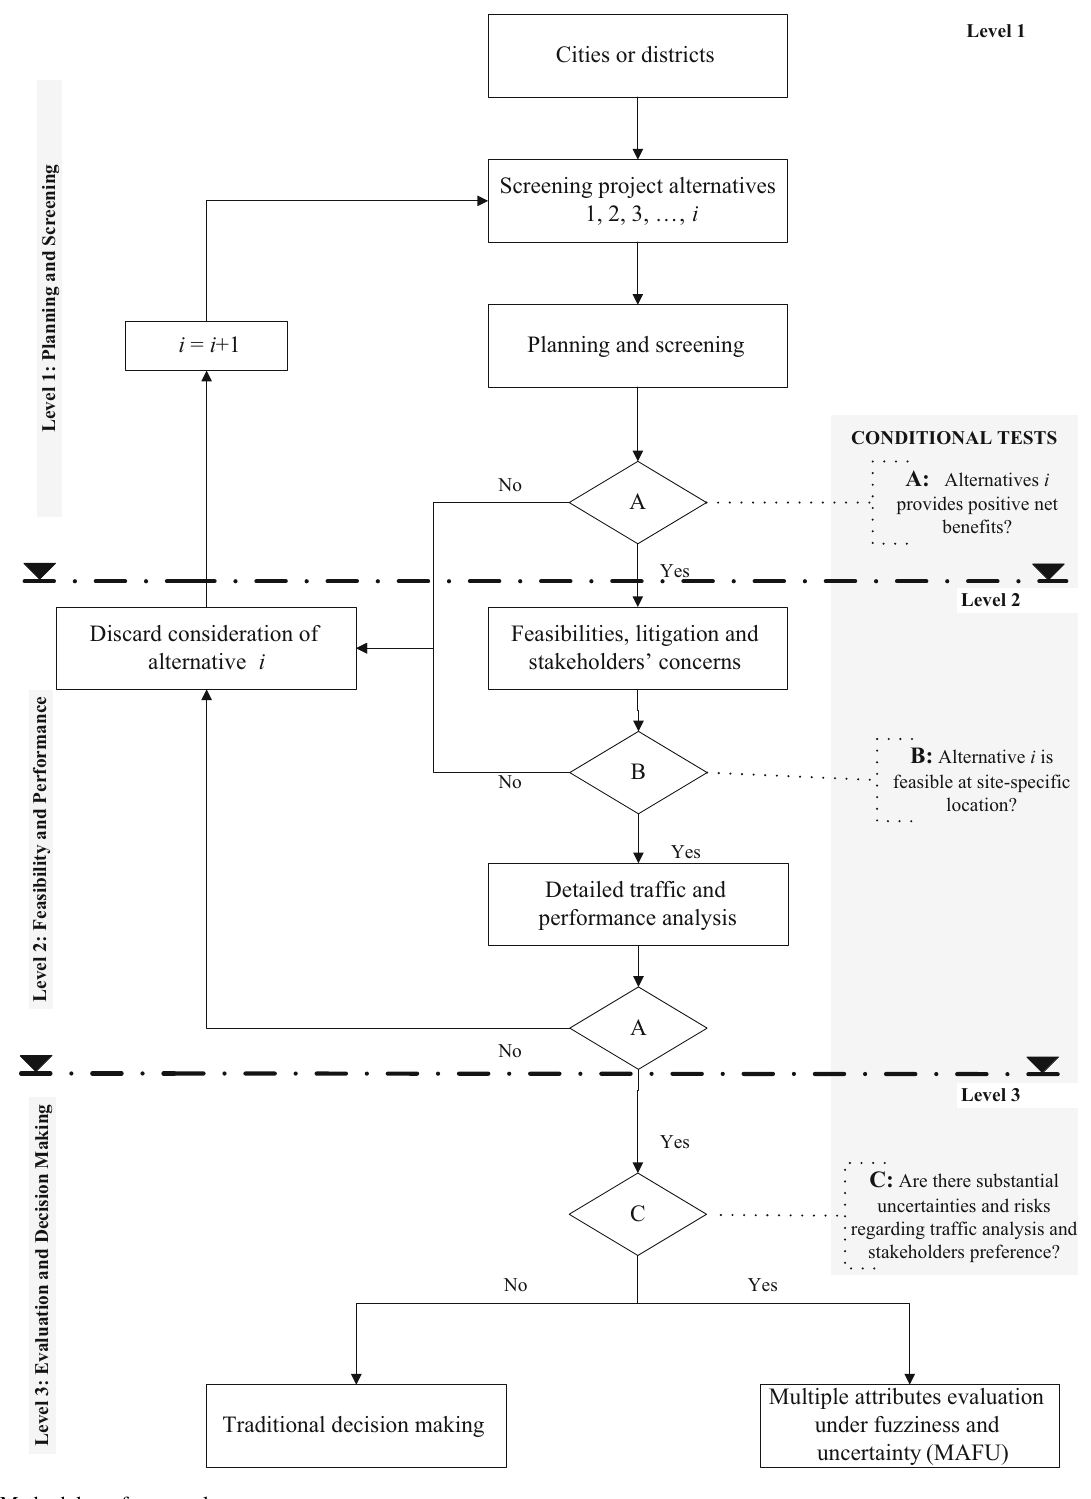
Fig. 1 Methodology